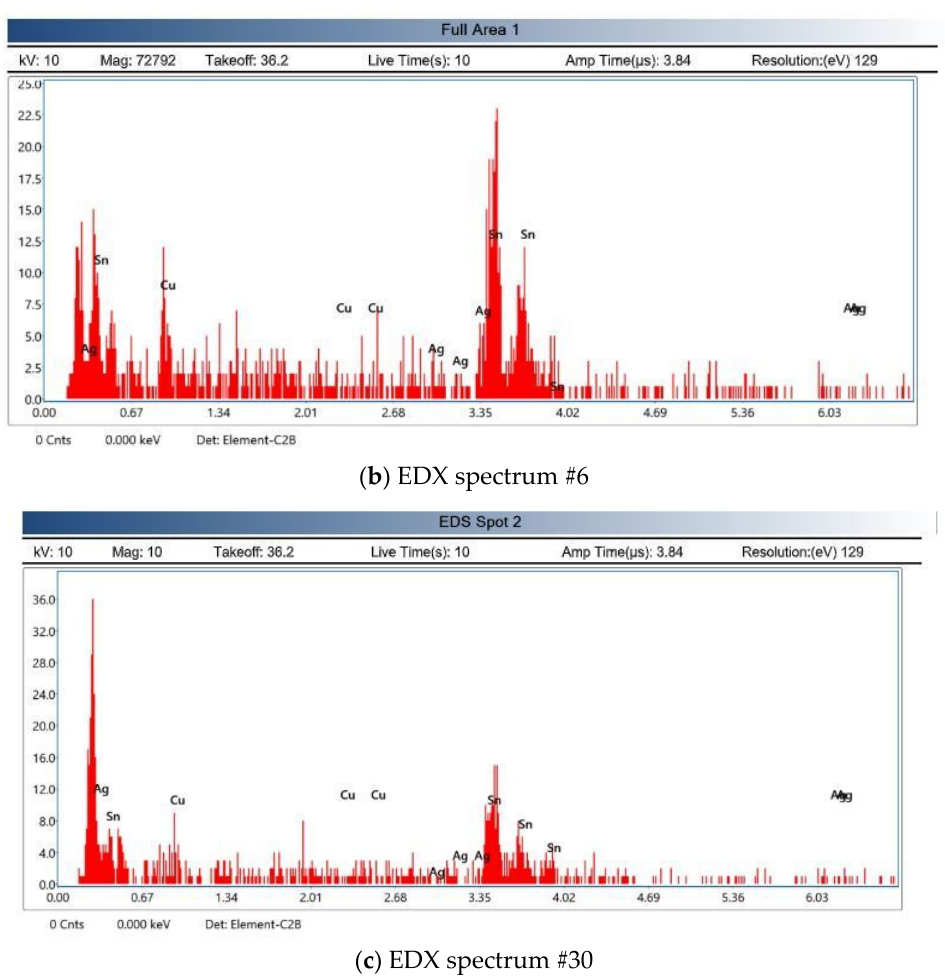
Figure 22. EDX spectrum of selected samples ( a ) #1, ( b ) #6, and ( c ) #30.